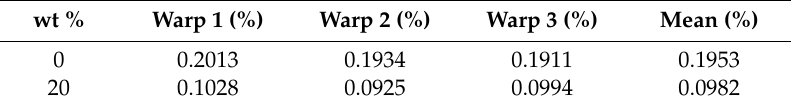
Table 5. Workpiece warp with di ff erent carbon contents.